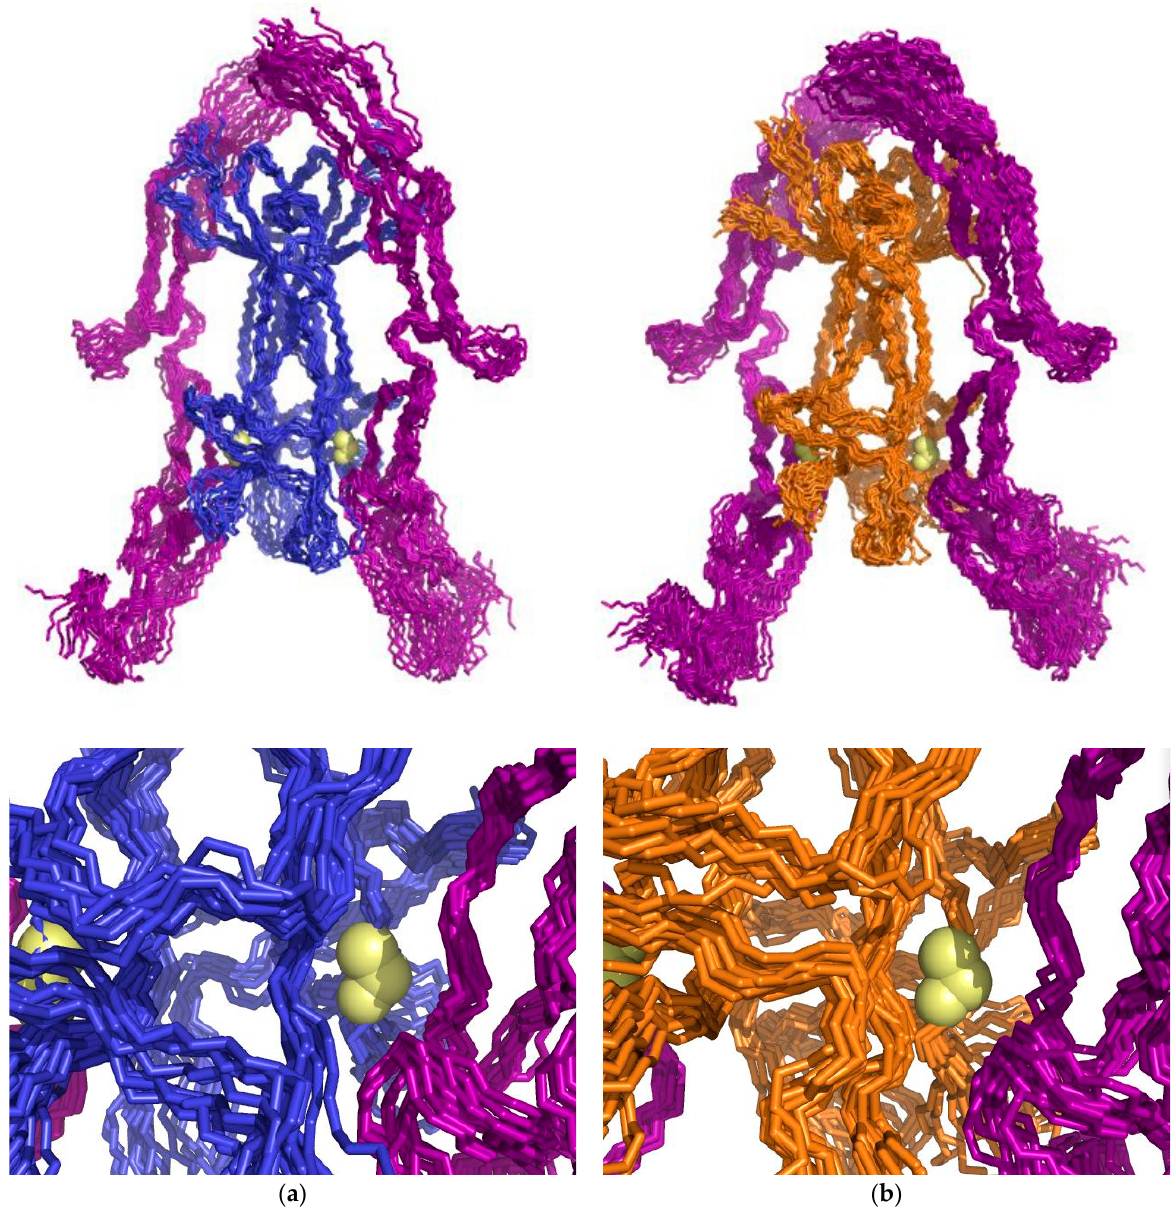
Figure 12. The structural ensembles generated by MD simulations for the complexes of p75NTR (in purple) with ( a ) proNGF WT (in blue) and ( b ) NGF R100W (in orange). The bundle of 10 most populated poses along the 100 ns simulation window for the overall complexes ( upper panel) and the detail of the contact surface involving position 100 with the chain X of p75NTR ( lower panel), whose backbone atoms are highlighted by yellow spheres, are shown. Figure produced by Pymol (Schrödinger LLC 2010).